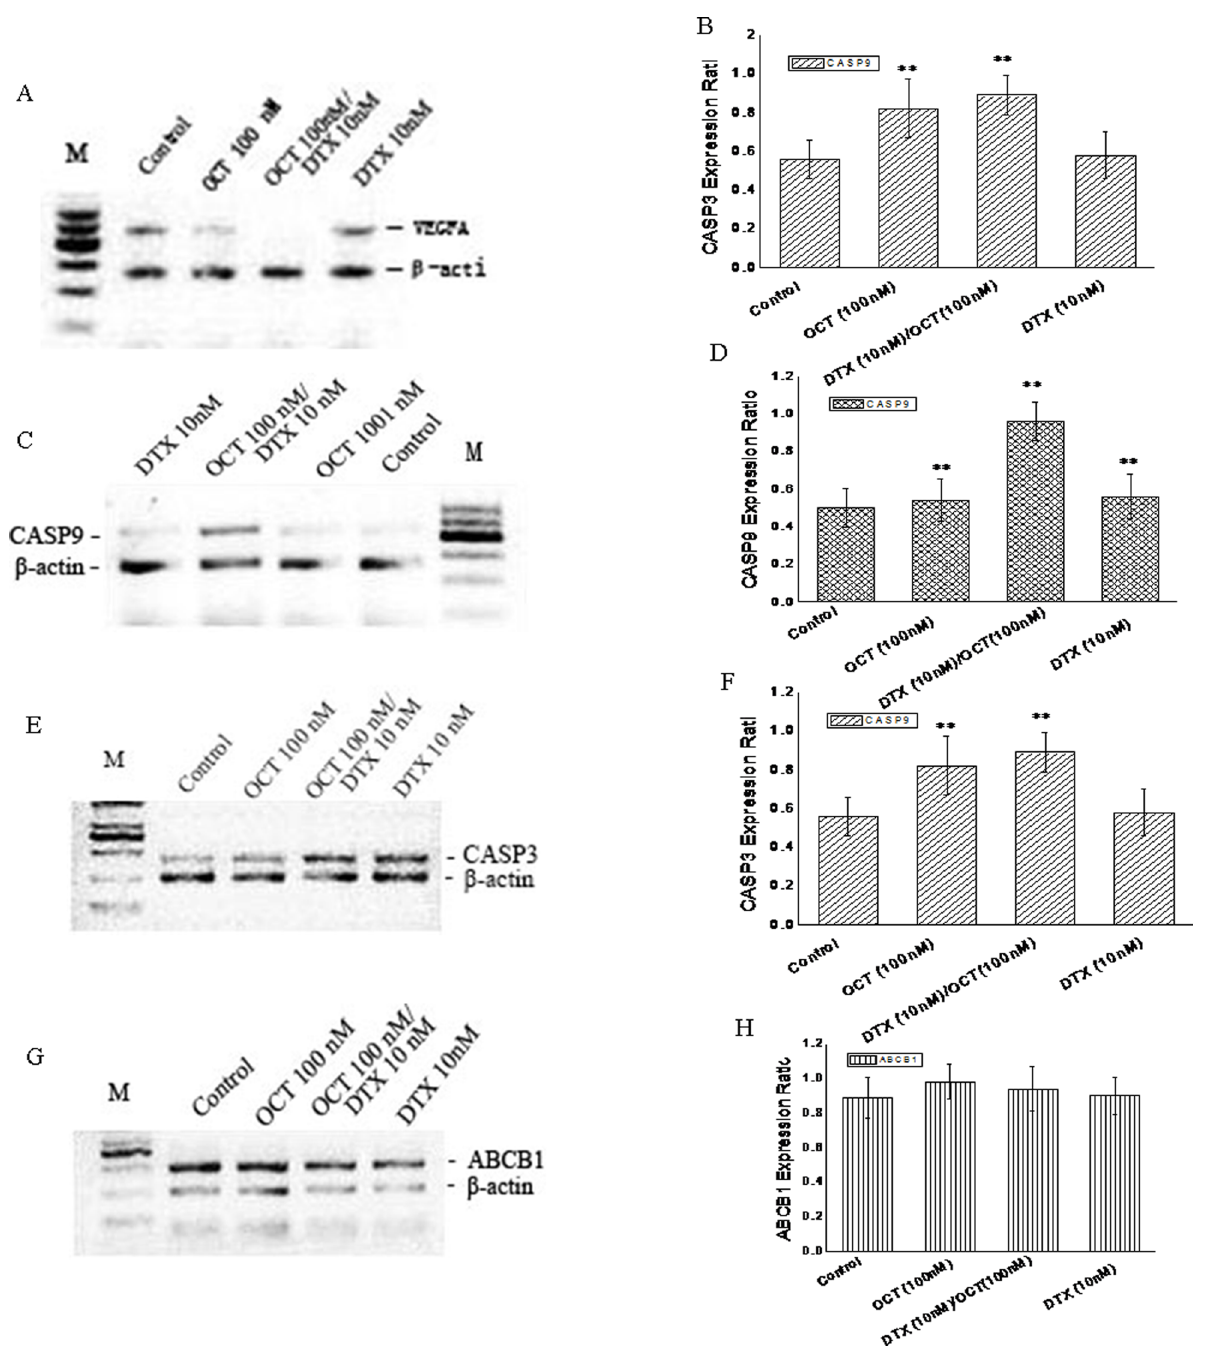
Figure 4. Effects of DTX, OCT alone and the combination of DTX/OCT on the mRNA expression of VEGFA, caspase 9, caspase 3 and ABCB1 in DU145 cells. M: Marker, The expression levels of objective genes were examined by RT-PCR (A, B, C and D) and quantitative real-time - PCR (B, D, F and H) respectively, using cells treated with the test drugs for 72 hours. The expression level of each mRNA was normalized to the level of b -actin mRNA. Values represent the means 6 SD of triplicate analyses (* p , 0.05, ** p ,